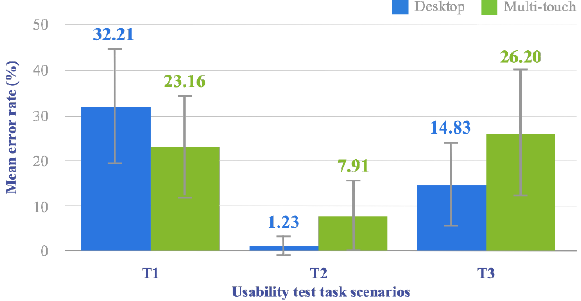
Figure 14. Mean error rate values for T1, T2 and T3 tasks performed both with Desktop and Multi- touch prototypes. Multi-touch prototypes.